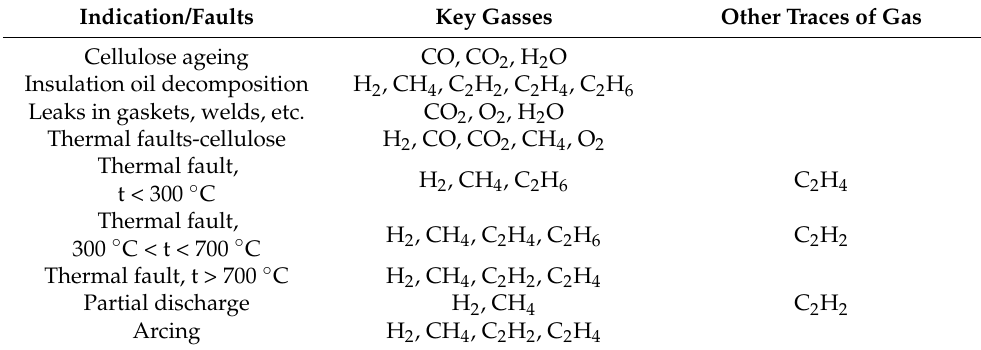
Table 2. Oil fault-based gas composition